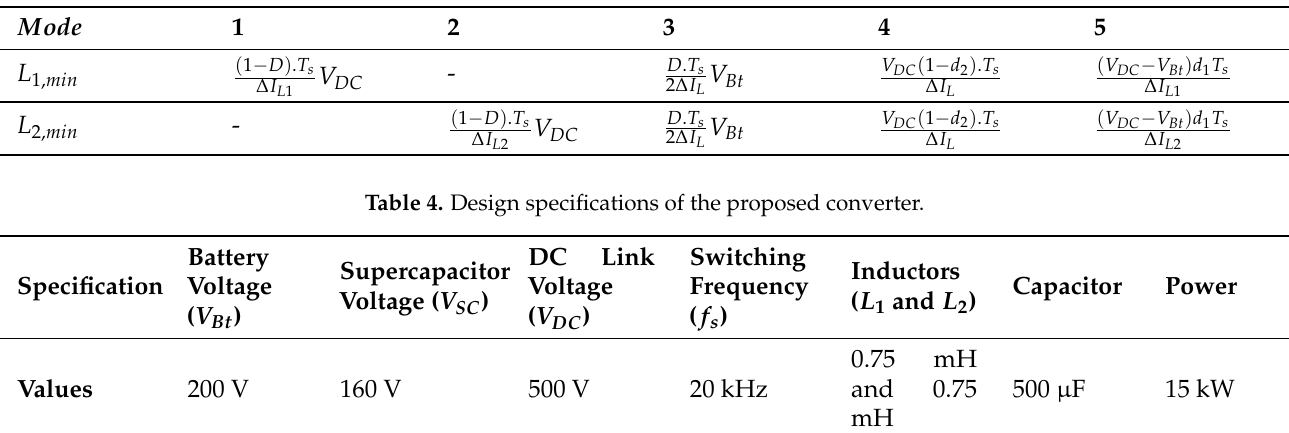
Table 3. Inductance equations in different operation modes.